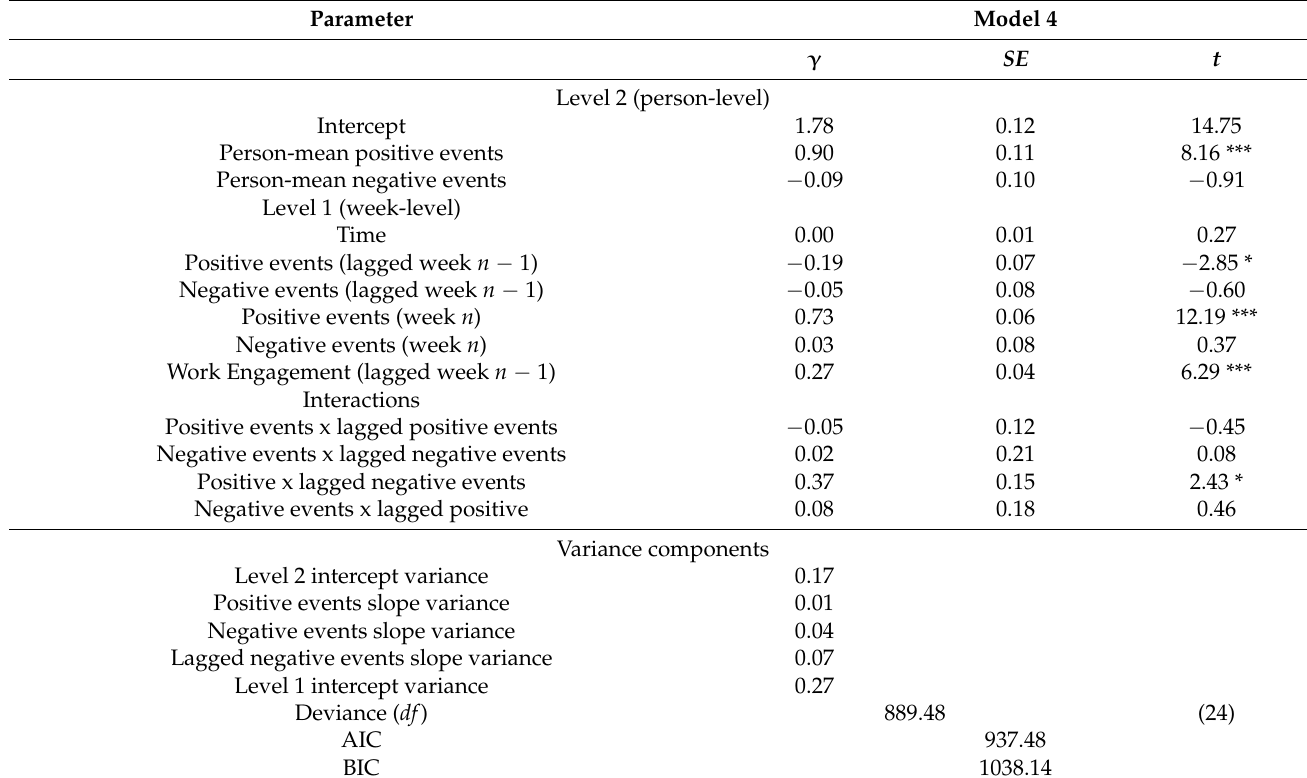
Table 6. Results from Multilevel Analysis Predicting Work Engagement in Week n Controlling for Work Engagement in Week n −